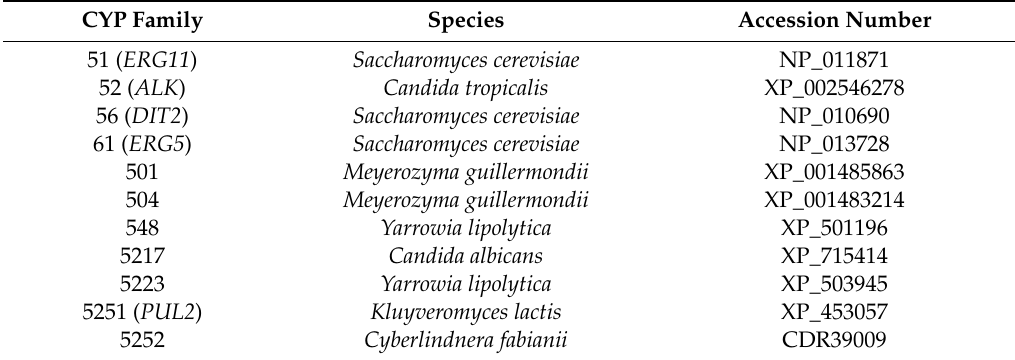
Table 1. CYP family reference